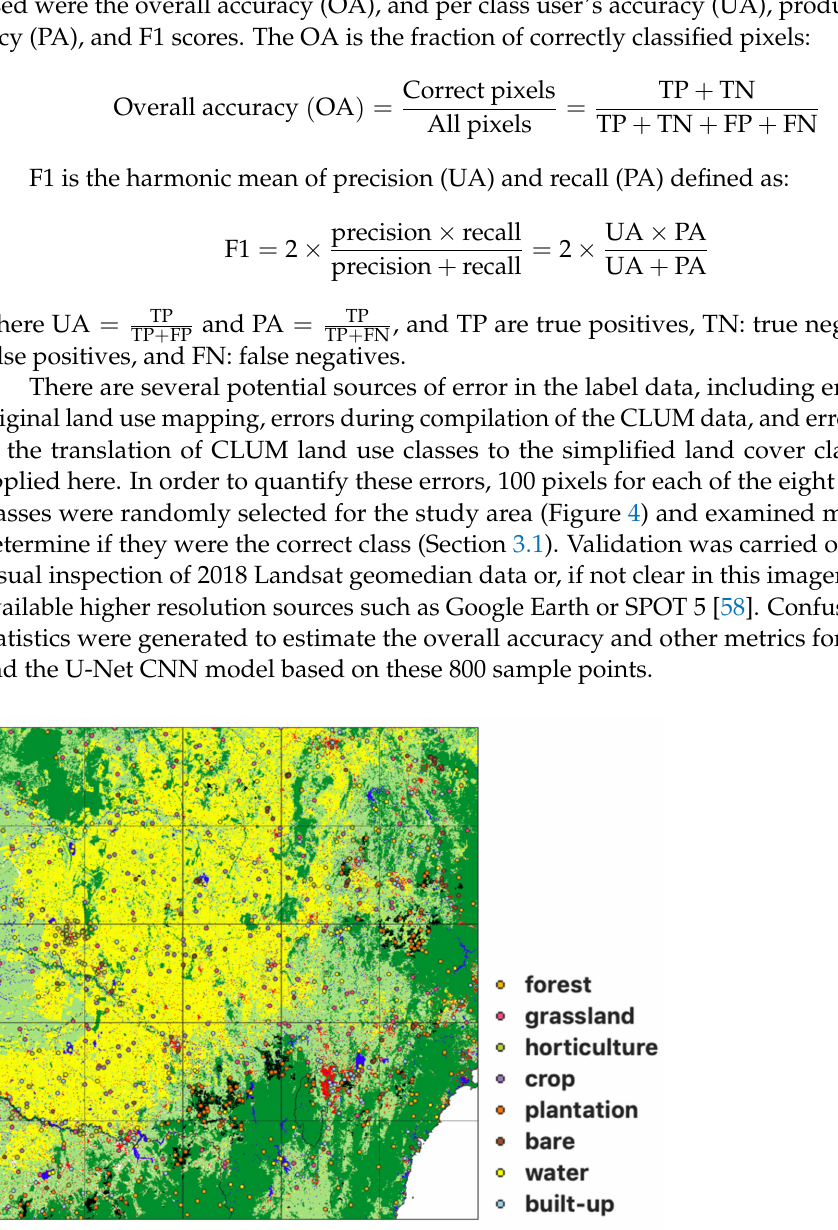
Figure 4. The 800 sample points of the study area (~500 km × 500 km) to evaluate label data and U-Net CNN model. See Figure 2 for colour legend of base